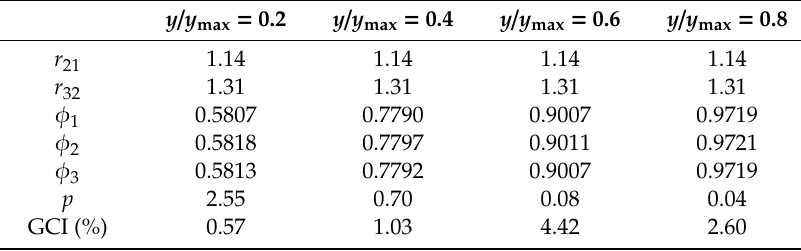
Table 2. Showcased calculations of GCI in V / V max. y / y max =